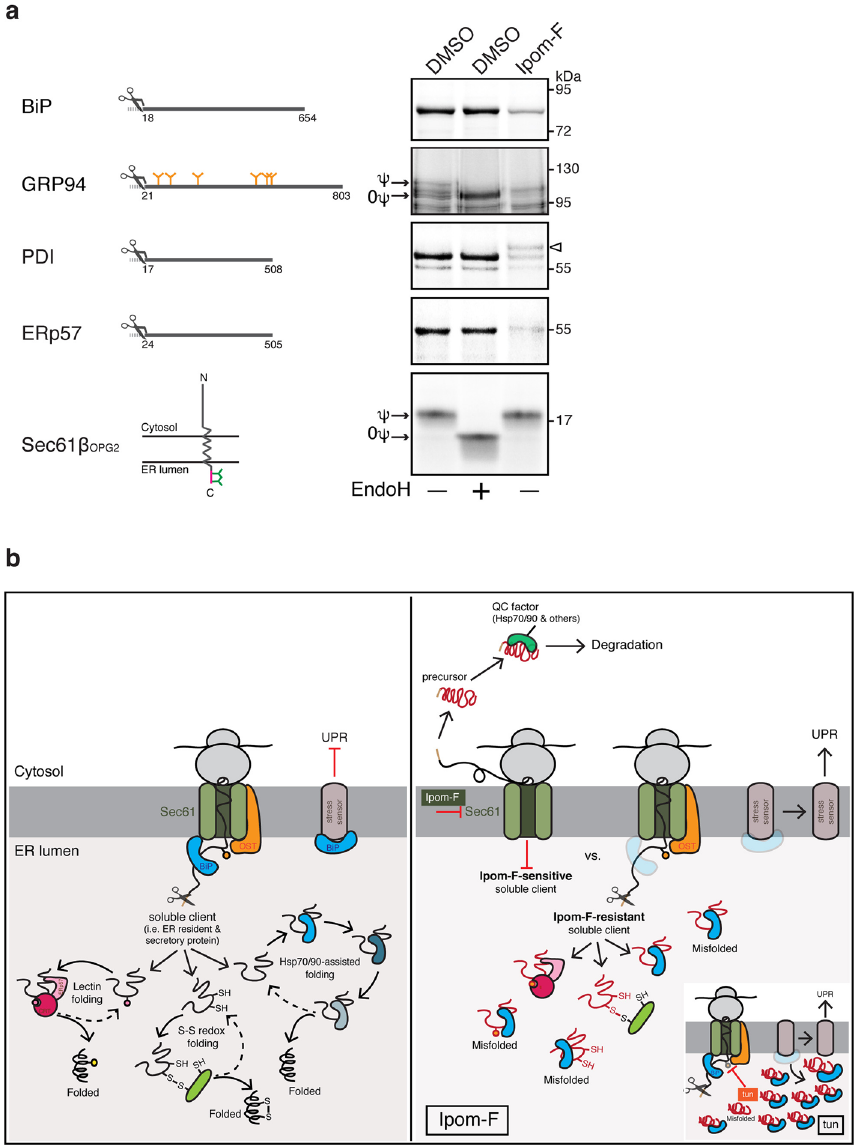
Figure 7. Ipom-F compromises the translocation of soluble ER-resident chaperones and folding factors. ( a ) Model soluble ER-resident folding factors and the tail-anchored protein Sec61β OPG2 were translated in rabbit reticulocyte lysate supplemented with [ 35 S]Met/Cys, canine rough microsomes and either DMSO or Ipom-F (1 μM), and the membrane-associated products were resolved by SDS-PAGE and analysed directly by phosphorimaging. Control samples were treated with EndoH to distinguish N-glycosylated (ψ) from non-glycosylated (0ψ) products. The position of the SP-uncleaved precursor of PDI is indicated with an arrowhead. Diagrams of preproteins showing the cleavage site of SPs (scissors symbol) and N-glycosylation sites (orange Y sites) are shown on the left. Representative phosphorimaging exposures are shown (full-length gels presented in Supplementary Fig. S5). ( b ) Proposed model of how the disruption of ER import by Ipom-F leads to ER stress. (Left) Under normal conditions, soluble ER clients, i.e. ER lumen residents and secretory proteins, are co-translationally translocated into the ER through the Sec61 translocon, often with the help from auxiliary components such as BiP. Shortly after, they engage ER lumen-resident chaperones and folding factors that promote protein folding and disulphide bond formation. ER stress sensors are maintained in an inactive form through BiP binding 73,74 . Protein N-glycosylation also occurs in the ER lumen during this phase of protein synthesis (not shown for simplicity). (Right) Ipom-F inhibits co-translational import of selected secretory proteins, such as α1AT, leading to the production of non-translocated precursors that mislocalise to the cytosol. These species appear to trigger the induction of cytosolic Hsp70/90 chaperones, which may contribute to a cytosolic quality control mechanism(s). Ipom-F-sensitive substrates also include central ER lumen-resident chaperones (BiP and GRP94) and other folding factors (PDI and ERp57), together with the type II integral membrane proteins ATF6, which acts as an ER stress transducer. These combined defects in ER translocation and ATF6-dependent stress signalling prevent the enhanced level of ER lumenal BiP that is seen after a tunicamycin-induced UPR and perturbs the folding of proteins such as FGA that still access the ER lumen in the presence of Ipom-F. These defects in ER function result in UPR signalling as evidenced by XBP1 mRNA splicing and increased levels of CHOP mRNA and ATF4 protein. (Right-inset) Tunicamycin inhibits protein N-glycosylation, which leads to the accumulation of incorrectly folded proteins in the ER. Increased demand for protein folding and degradation induces ER stress and activates UPR signalling. Dissociation of BiP from the ER stress sensors has been proposed to activate the UPR 73,74